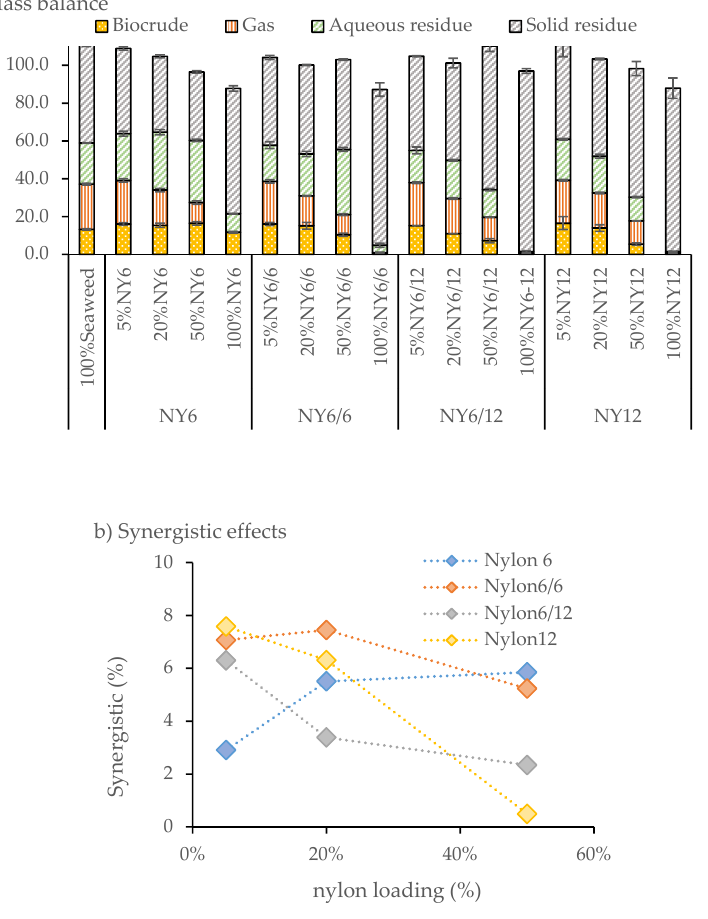
Figure 2. ( a ) Mass balance of the products from the hydrothermal liquefaction (HTL) reaction conversion of Fucus serratus and nylon 6 (NY6), nylon 6/6 (NY6/6), nylon 6/12 (NY6/12) and nylon 12 (NY12); ( b ) synergistic effects on biocrude yields of Fucus serratus and nylon 6 (NY6), nylon 6/6 (NY6/6), nylon 6/12 (NY6/12) and nylon 12 (NY12).